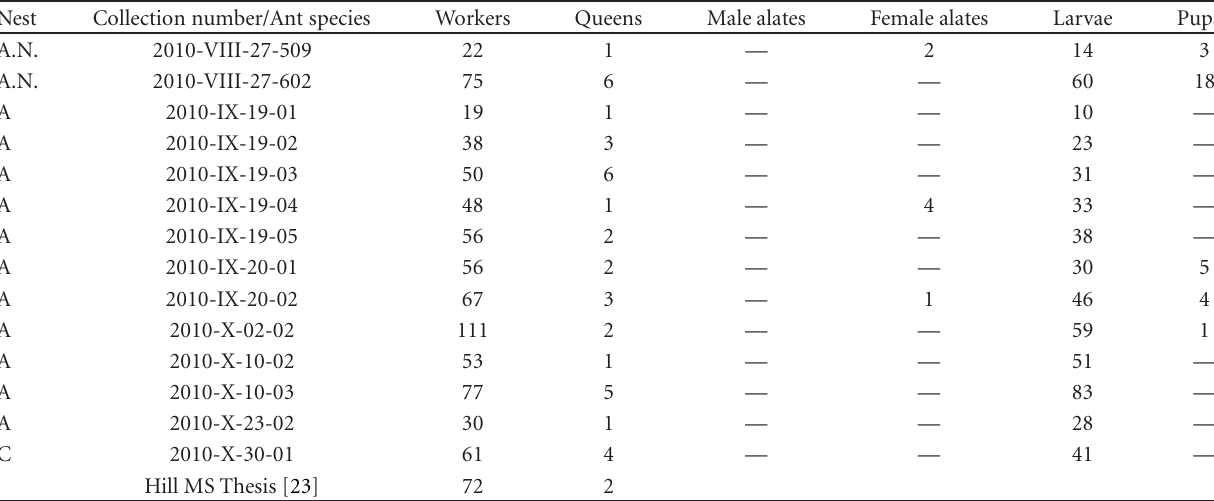
Table 2: Demographic data on Pyramica ohioensis colonies recovered in this study [Montgomery Co., MD]. Nest Collection number/Ant